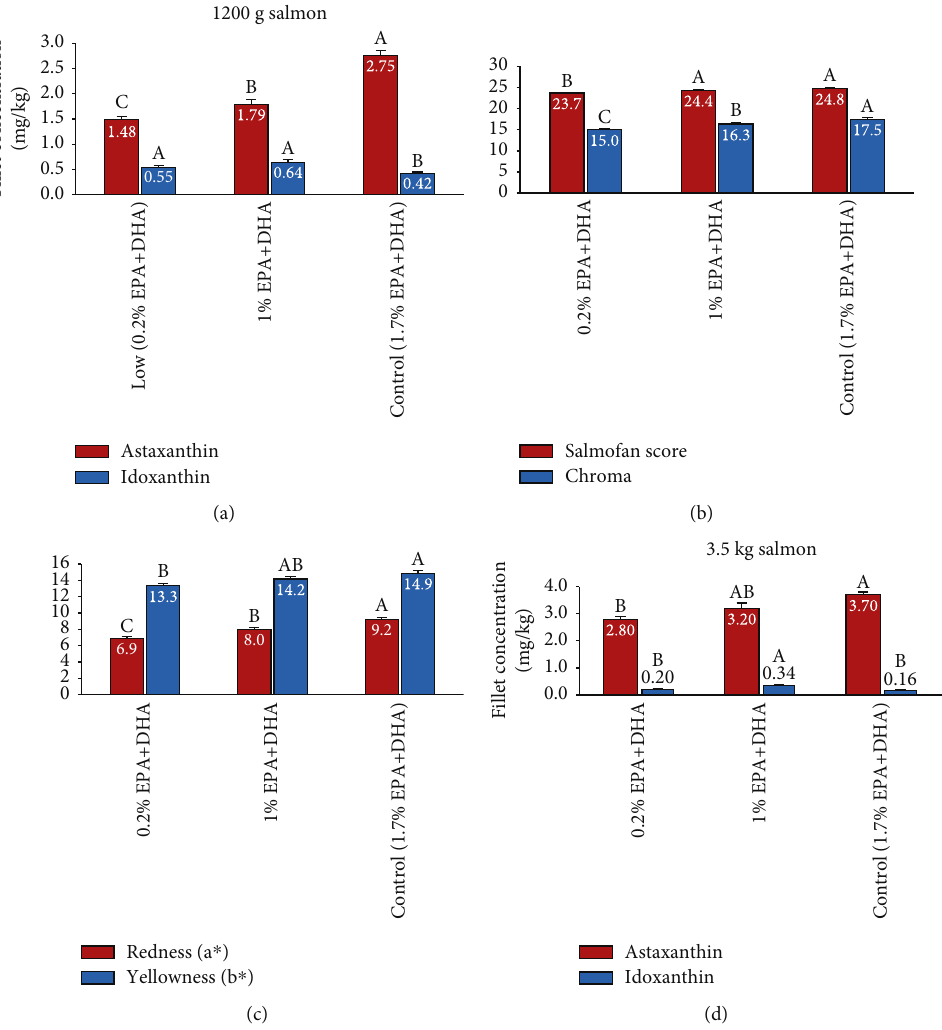
Figure 2: Visual color and concentration of astaxanthin and idoxanthin in salmon fi llets at 1200g. Data from fi sh fed, the 7 di ff erent diets in period 1 (50 – 400 g) are pooled. (a) fi llet astaxanthin and idoxanthin, (b) Salmofan and chroma of fi llets, c) Minolta redness (a ∗ ) and yellowness (b ∗ ), and (d) Fillet concentration of astaxanthin and idoxanthin at 3.5 kg. Values are means per treatment ð diet period2 Þ ± SEM . Means labelled with common letters are not signi fi cantly di ff erent ( P < 0 : 05